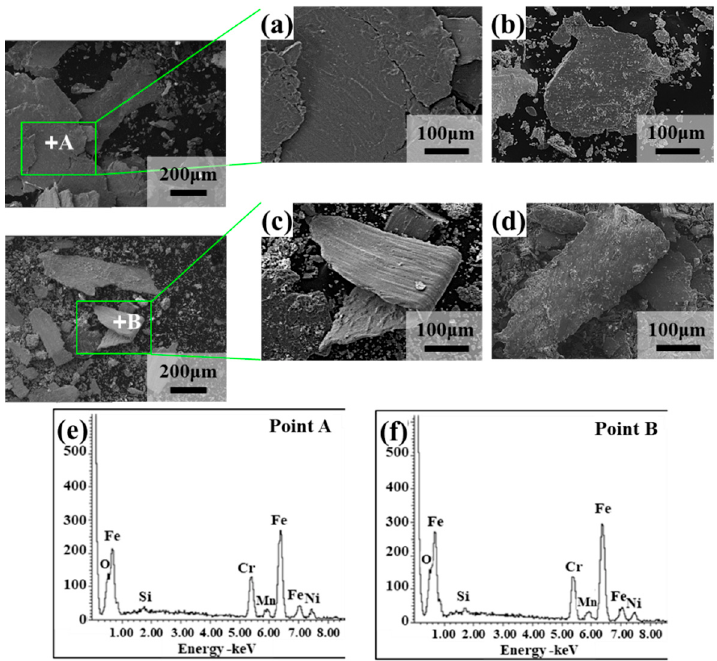
Figure 5. Morphologies of debris collected at the end of wear tests and corresponding EDS analysis; SEM micrographs of plate-like debris from SUS304 obtained under ( a ) dry and ( b ) wet conditions, SUS316 under ( c ) dry and ( d ) wet conditions, and EDS patterns for ( e ) point A and ( f ) point B.